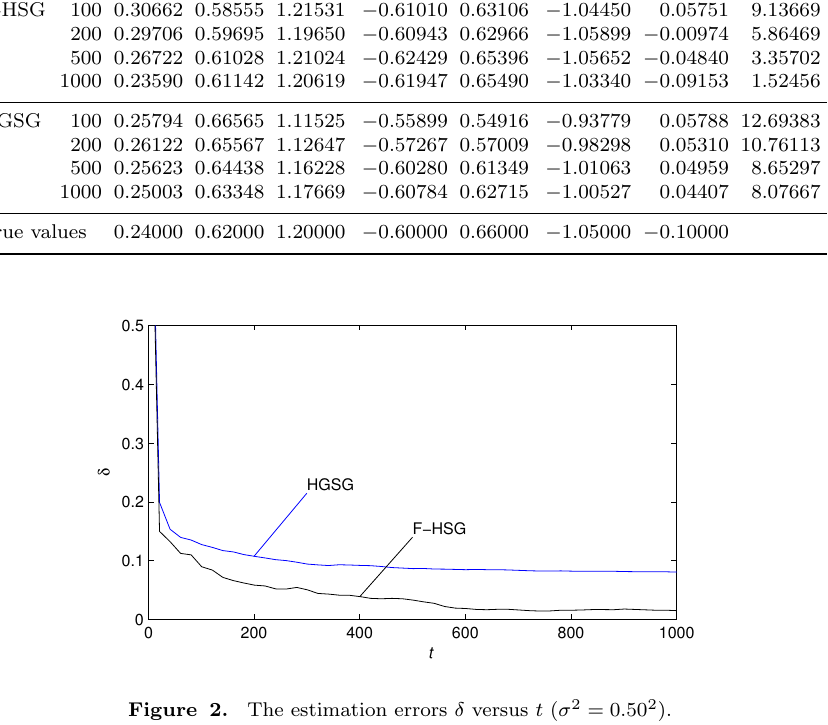
Table 1. The F-HSG and HGSG estimates and their errors ( σ 2 = 0 . 50 2 ). Algo- t rithms